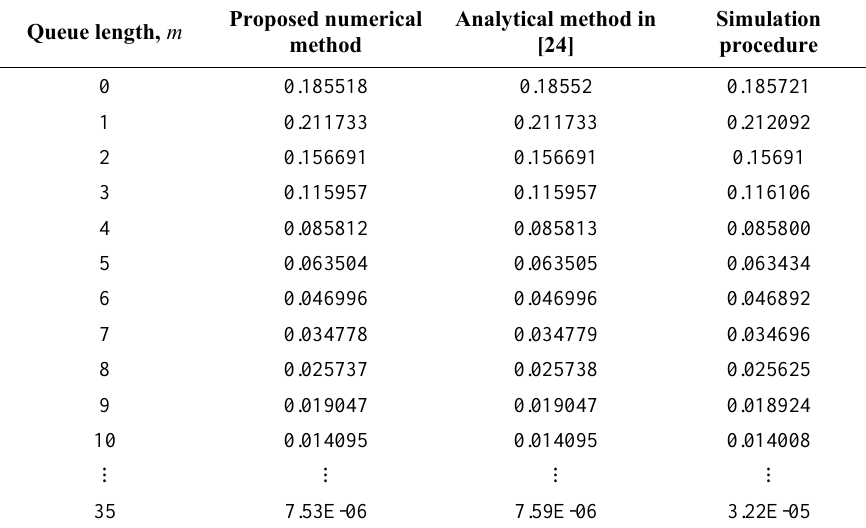
Table 1. Stationary queue length distribution computed from the proposed numerical method, generating function method and simulation procedure ()()